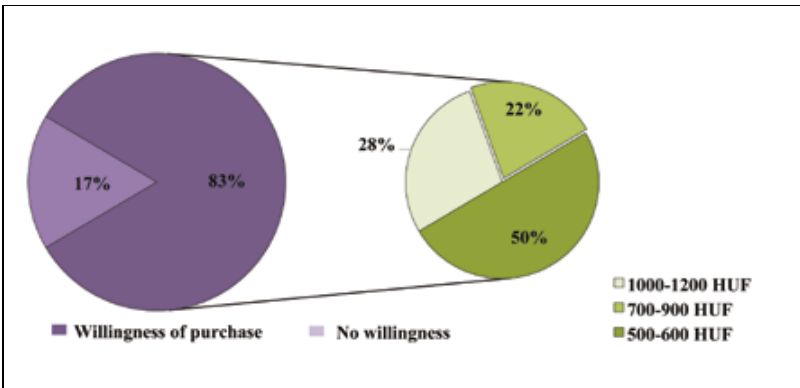
Figure 8. Willingness of purchase (%) and the acceptable price (HUF) by